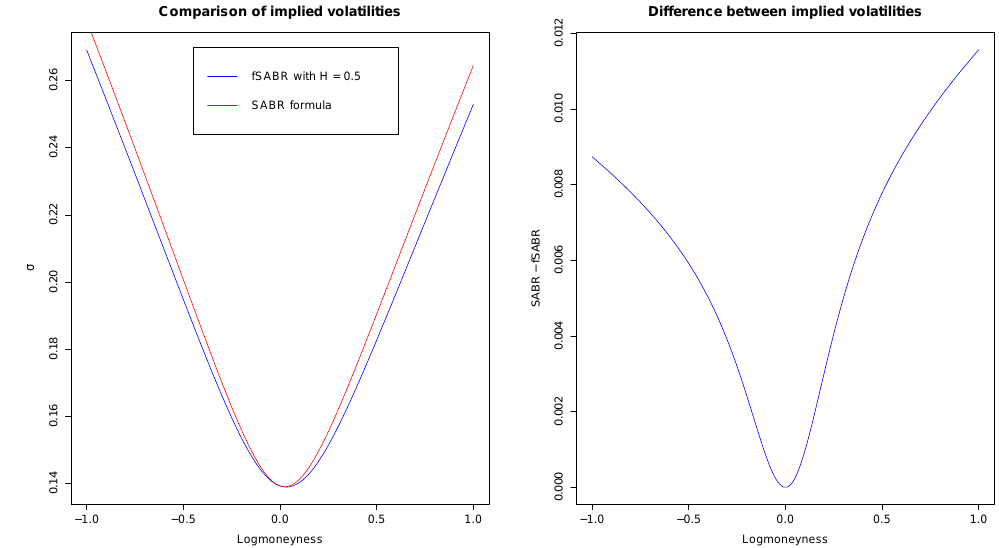
Figure 2. The plot on the left shows the approximate implied volatility curves versus logmoneyness with time to expiry t = 1 produced by (20) (in blue) the SABR Formula (3) (in red). Parameters are set as ρ = − 0.06867, ν = 0.5778, a 0 = 0.13927. The plot on the right shows the difference between the two curves.